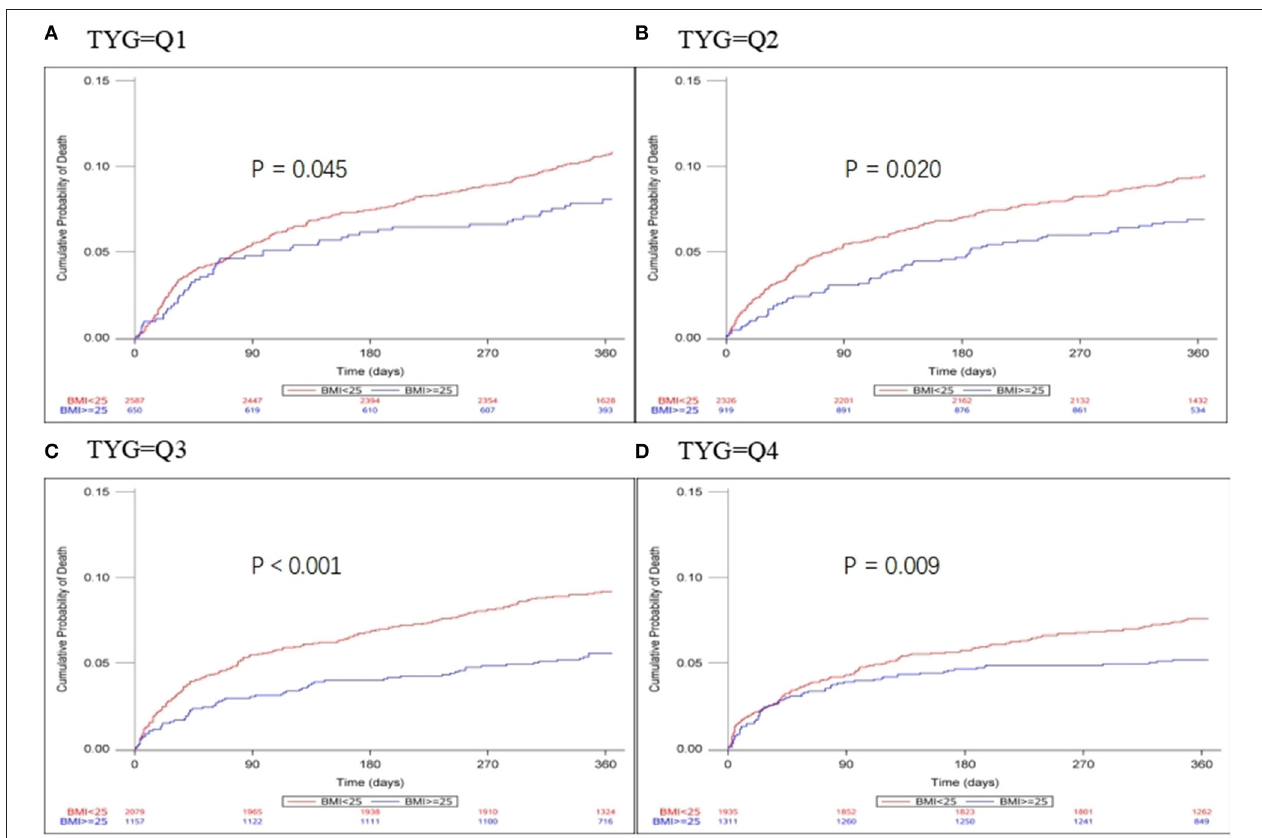
TABLE 4 | Influence of TYG index as a continuous variable on the relationship between BMI and stroke. Outcome BMI Crude HR/OR Stroke